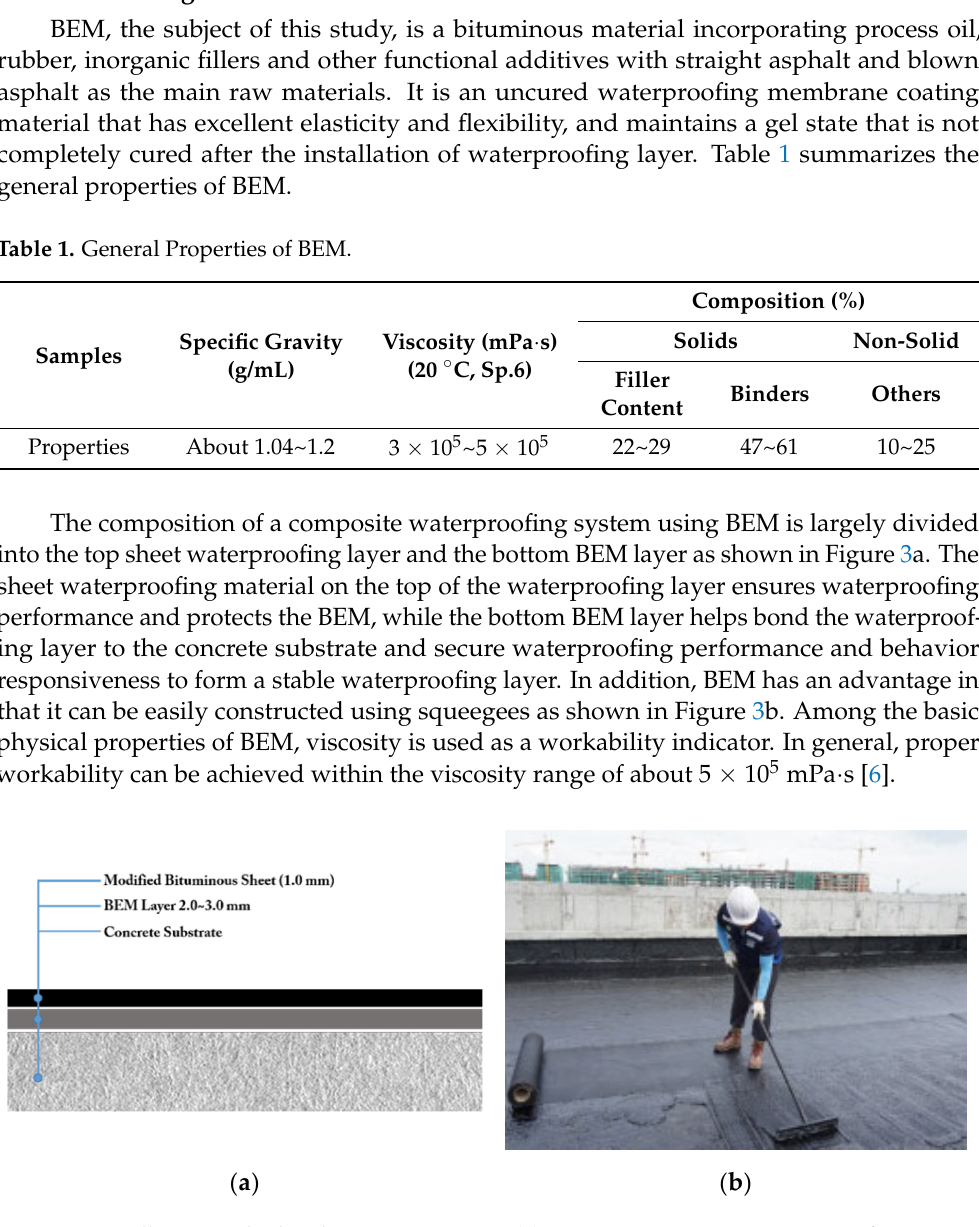
Figure 3. Installation method and status using BEM: ( a ) composite using BEM waterproofing system composition diagram; ( b ) BEM installation status.